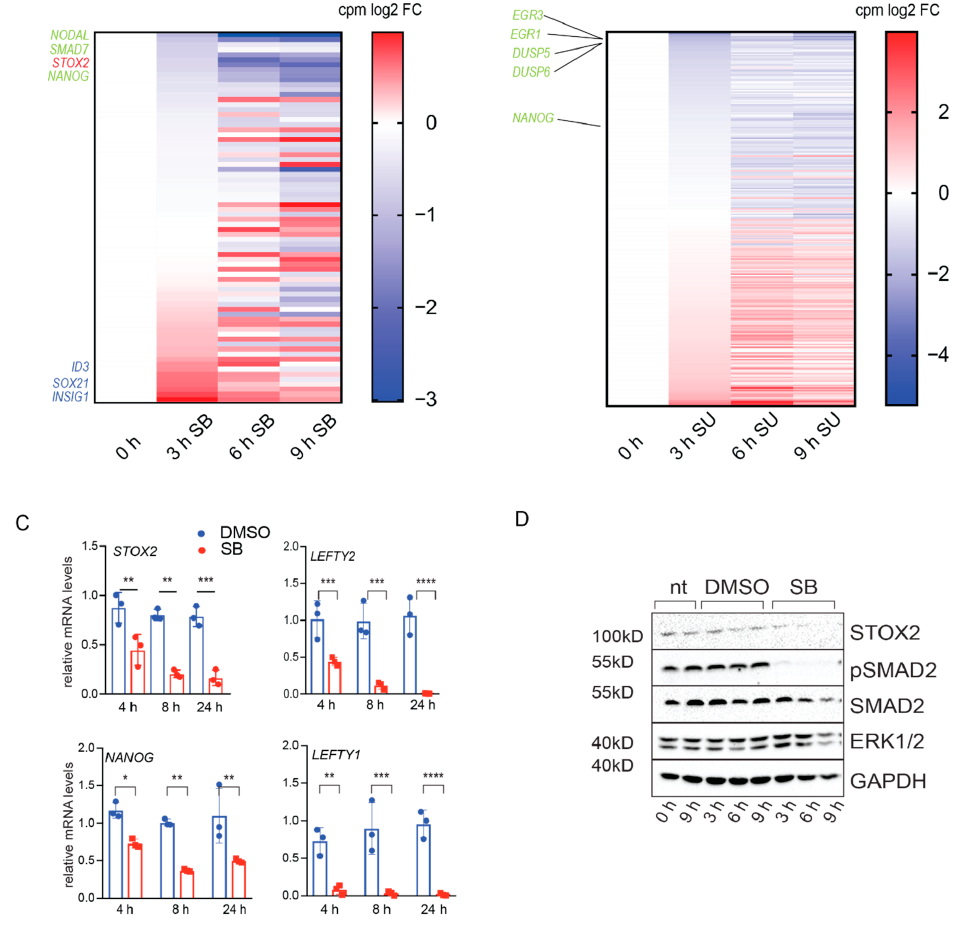
Figure 2. Identification of STOX2 as a novel TGF- β target. ( A ) Heatmap of log2 fold change counts per million (compared to DMSO) of SB regulated target genes. ( B ) Heatmap of log2 fold change counts per million (compared to DMSO) of SU regulated target genes. ( C ) mRNA expression levels of STOX2, NANOG, LEFTY1 and 2 in hESCs (H1) were determined by RT-qPCR after inhibition of TGF- β signaling by 10 µM SB43152 for 4, 8, and 24 h. Treating cells with DMSO served as control. mRNA levels were calculated relative to GAPDH and HPRT using the ΔΔ Ct method. (N = 3, average ± SD, p -value * p < 0.05, ** p < 0.01, *** p < 0.001, **** p < 0.0001, ordinary 2-Way ANOVA, Sidak’s multiple comparisons). ( D ) Immunoblot showing STOX2 protein levels in hESCs after 3, 6 and 9 h of TGF- β inhibition by SB (10 µ M). Untreated and DMSO treated cells served as controls. E ffi cient inhibition of TGF- β signaling was monitored by pSMAD2 levels. Equal loading was confirmed with antibodies against SMAD2, ERK1 / 2 and GAPDH. Representative images of three independent experiments are